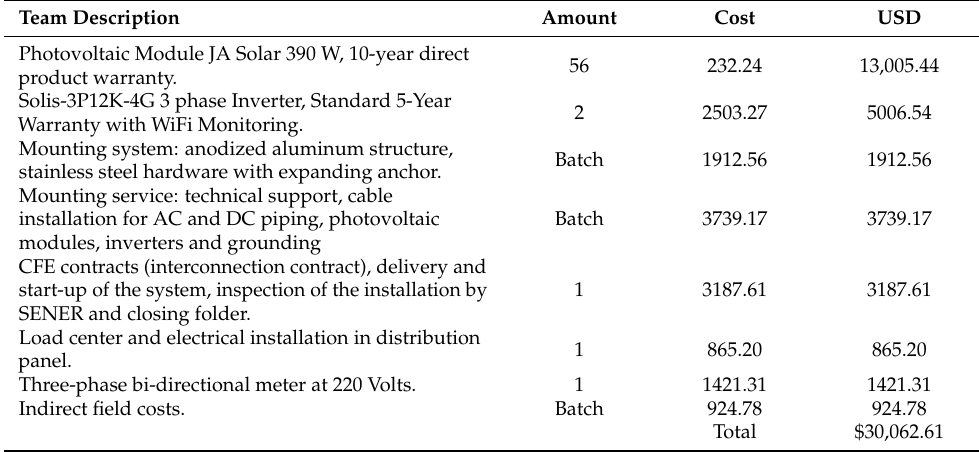
Table 8. Construction costs of the Grid-Connected Photovoltaic Systems (On Grid-PV) in USD. Team